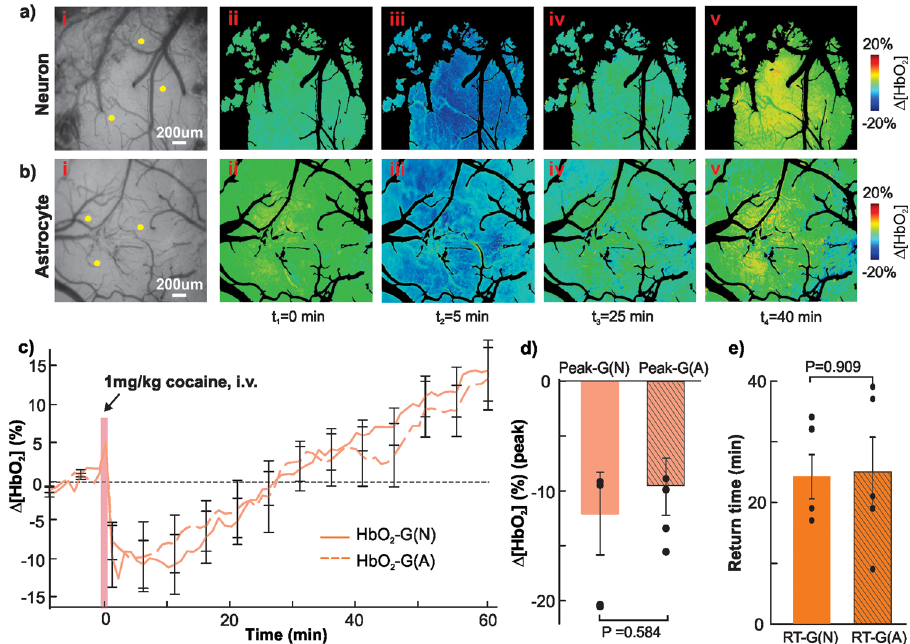
Fig. 3 Comparison of cocaine-induced tissue oxygenated-hemoglobin (HbO 2 ) changes between Group N (neuronal) and Group A (astrocytic) mice. a , b Time lapse Δ [HbO 2 ] images in response to cocaine (1mg/kg, i.v) in a Group N animal (ii – v) and a Group A animal (ii – v) at t = 0, 5, 25, 40min, respectively. Three ROIs were selected in tissue (e.g., yellow dots) from each animal. c Mean Δ [HbO 2 ] changes with time in response to cocaine (1mg/kg, i.v) in Group N (solid line, n = 5) and Group A (dashed line, n = 5), showing cocaine-induced Δ [HbO 2 ] decrease in cortical tissue over 20 – 25min followed by an overshoot over baseline about 10 – 15% at t = 60min after cocaine. d Comparison of peak Δ [HbO 2 ] decreases between G(N) and G(A), showing no difference ( n = 5, p = 0.584). e Comparison of Δ [HbO 2 ] return time to baseline between G(N) and G(A), showing no difference ( n = 5, p = 0.909). All error bars are presented as means